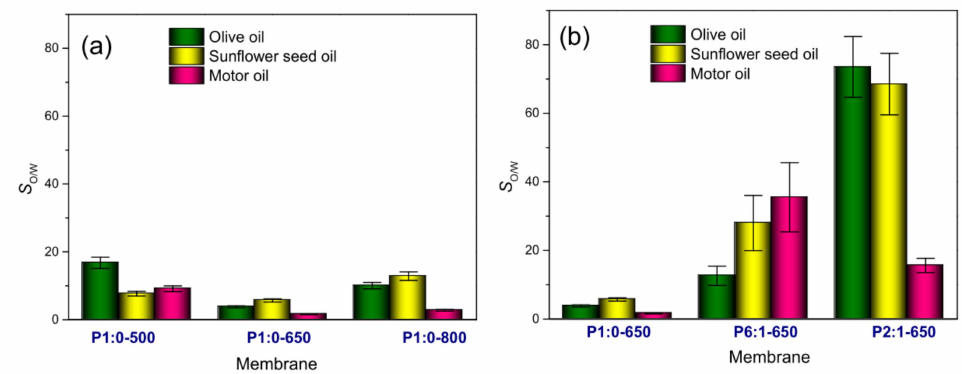
Figure 9. Oil/water selectivity ( S O/W ): effect of ( a ) the carbonisation temperature of PAN-derived membranes, and ( b ) PAN:PMMA mass ratio of blend-derived membranes carbonised at 650 ◦ C. For an easier comparison, in the two plots, the same vertical scale is